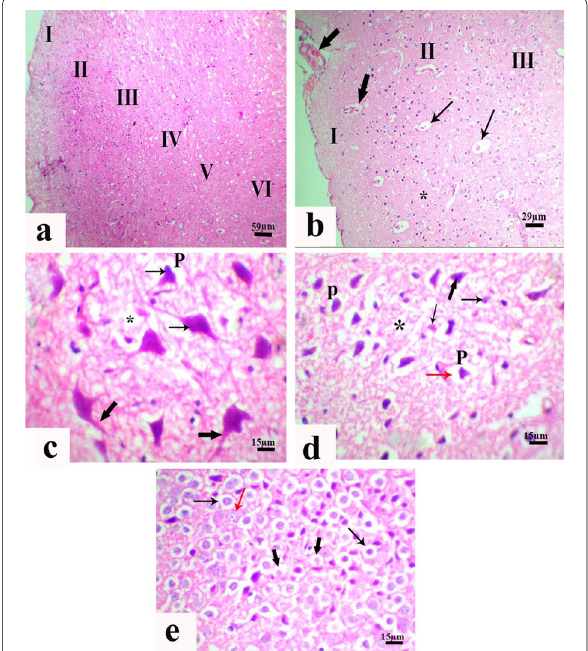
Fig.3 photomicrographs of sections of the cerebral cortex of reserpine-treated rats showing a : neuronal disorganization of all cerebral cortex layers I, II, III, IV, V and VI. b : loss of architectural details of layer (I), (II), (III), dilated congested blood vessel (thick arrows), degenerative vacuolization (thin arrows) and intercellular edema (*). c : the eosinophilic pyramidal cells (P) with dark stained nuclei (thin arrows), thick tortuous (thick arrows) surrounded with vacuolated neuropil (*). d : degenerated pyramidal cell (P) with pericellular halos (red arrow), pyknotic nuclei (thick arrow) or karyorrhectic (thin arrows) and degenerated neuropil (*). e : internal granular layer with; the degenerated granule cells surrounded by pericellular halos (thin arrow), apoptotic cell with nuclear chromatin lysis (thick arrows) and swollen neuron (red arrow)